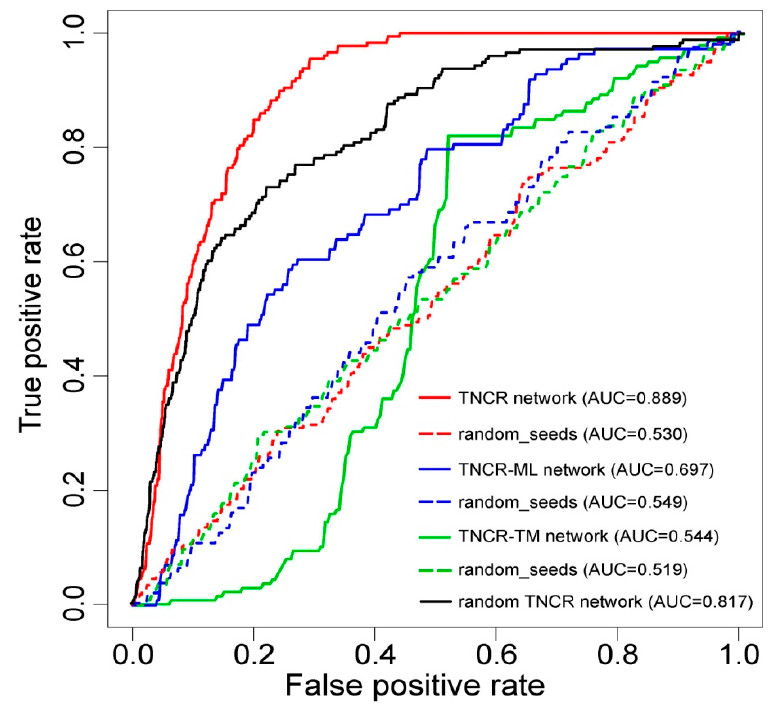
Figure 2. Receiver operating characteristic (ROC) curves and area under the curve (AUC) values for the random walk with restart (RWR) method on the whole, partial and random TNCR networks with real seeds and random seeds. The ROC curves were plotted and AUC values were calculated separately by leave-one-out cross-validation (LOOCV) for the TNCR network, TNCR-ML (miRNAs and lncRNAs only) network, TNCR-TM (TFs and miRNAs only) network and the random TNCR network with real and random seeds.